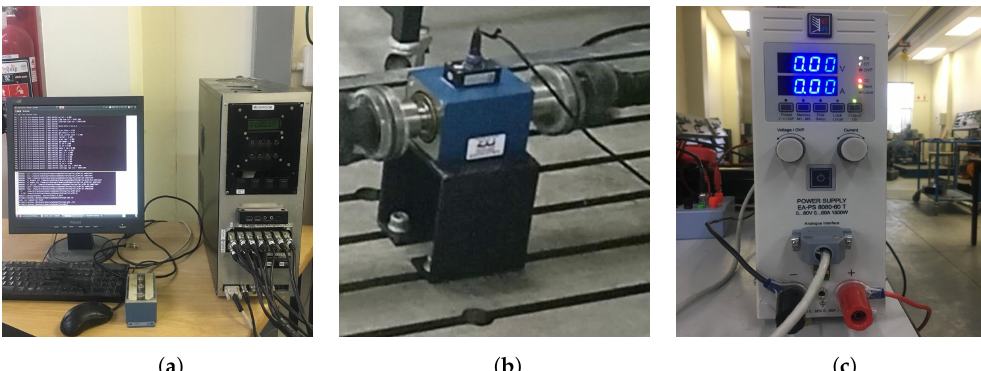
Figure 20. Practical system setup.